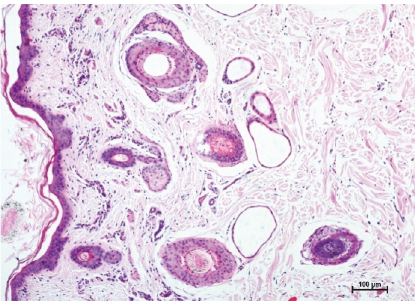
Figure 6: Photomicrographs from neck lateral region of skin showing sweat gland (Swg) and capillary Network (Cp). Masson, s trichrome X 400.